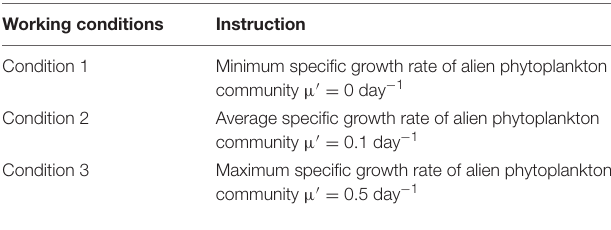
TABLE 1 | Working conditions setting of phytoplankton community specific growth rate in each